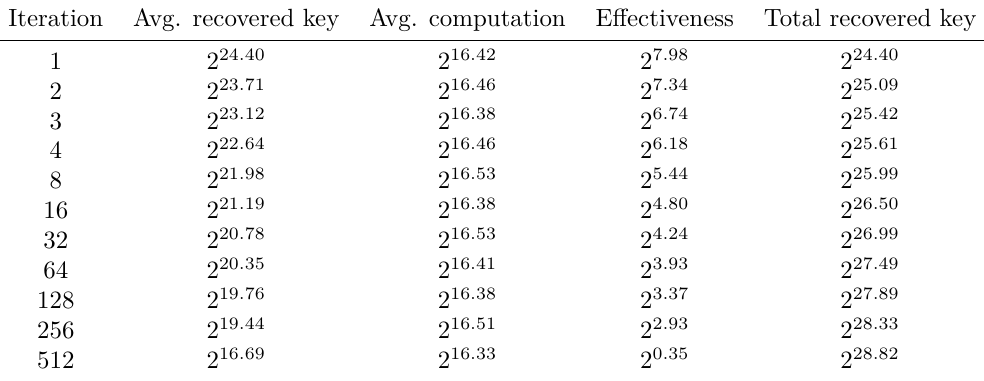
Table 3: Results on Algorithm 2 ( κ = 32 , ν = 256).